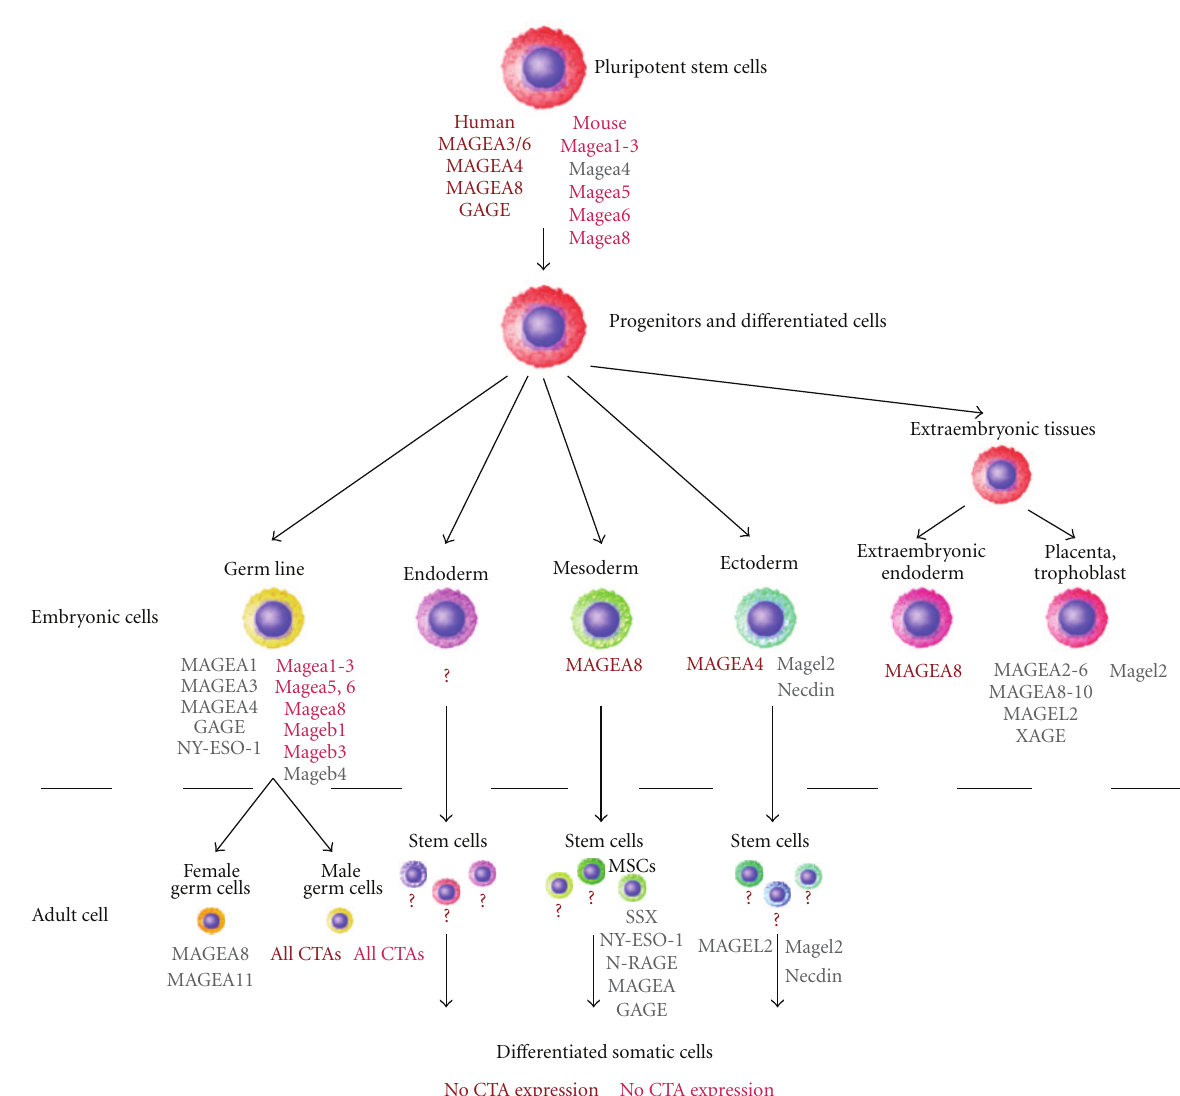
Figure 6: CTAs expression in pluripotent cells and derivatives of di ff erent lineages. Data are summarized from present study (marked by brown and red) and [29–31, 34, 47–50, 52–57]. Human CTAs are marked with capital